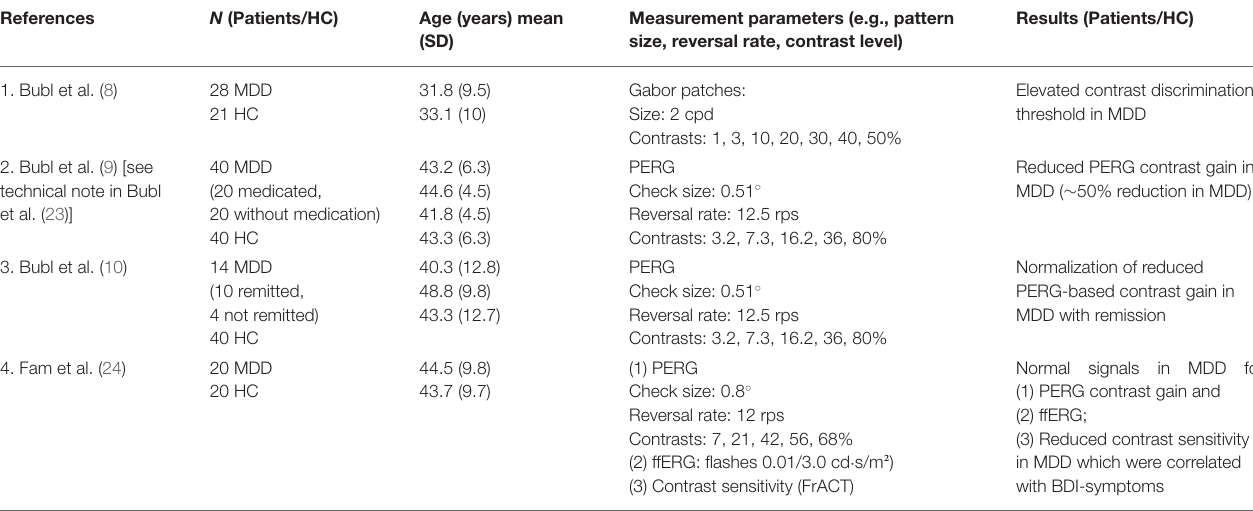
TABLE 1 | Previous studies on contrast sensitivity and/or PERG responses in patients with major